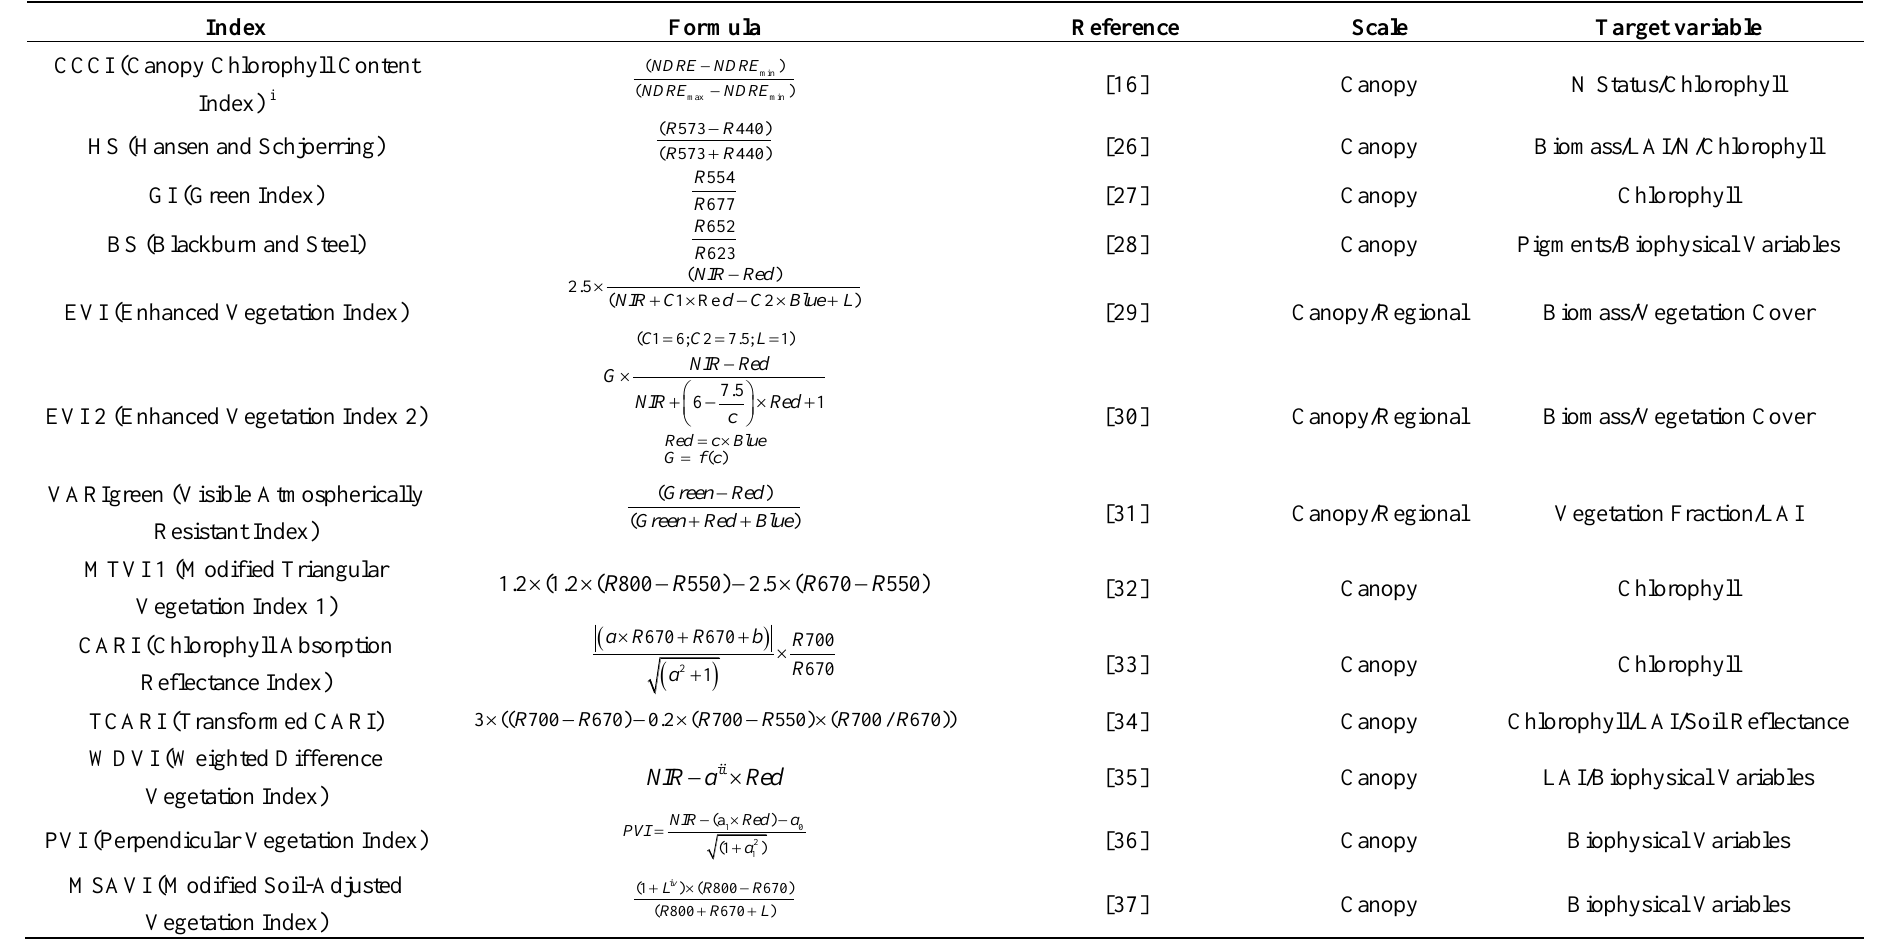
Table 1. Vegetation indices used in this study. NDRE, Normalized Difference Red Edge; LAI, Leaf Area Index; NIR,